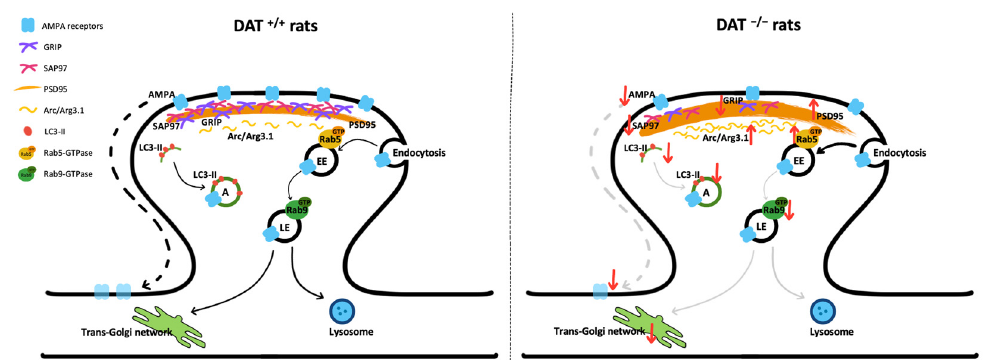
Figure 6. Schematic representation of the changes observed in the glutamatergic synapse in the PFC of DAT − / − rats. The condition of hyperdopaminergia caused by DAT deletion alters the trafficking of AMPA receptors and their scaffolding protein expression. Changes in the endosomal and autophagic mechanisms are paralleled with the impairment of the glutamatergic synapse. AMPA , glutamate-amino-3-hydroxy-5-methyl-4-isoxazole propionic acid receptors; SAP97, synapse-associated protein 97; GRIP, glutamate receptor-interacting protein; PSD95. postsynaptic density protein 95; Arc/Arg3.1, Activity-regulated cytoskeleton-associated protein; Rab5, Ras-associated binding protein 5; Rab9, Ras-associated binding protein 9; LC3-II, microtubule-associated proteins 1A/1B light chain 3B; EE, early endosome; LE, late endosome; A, autophagosome.